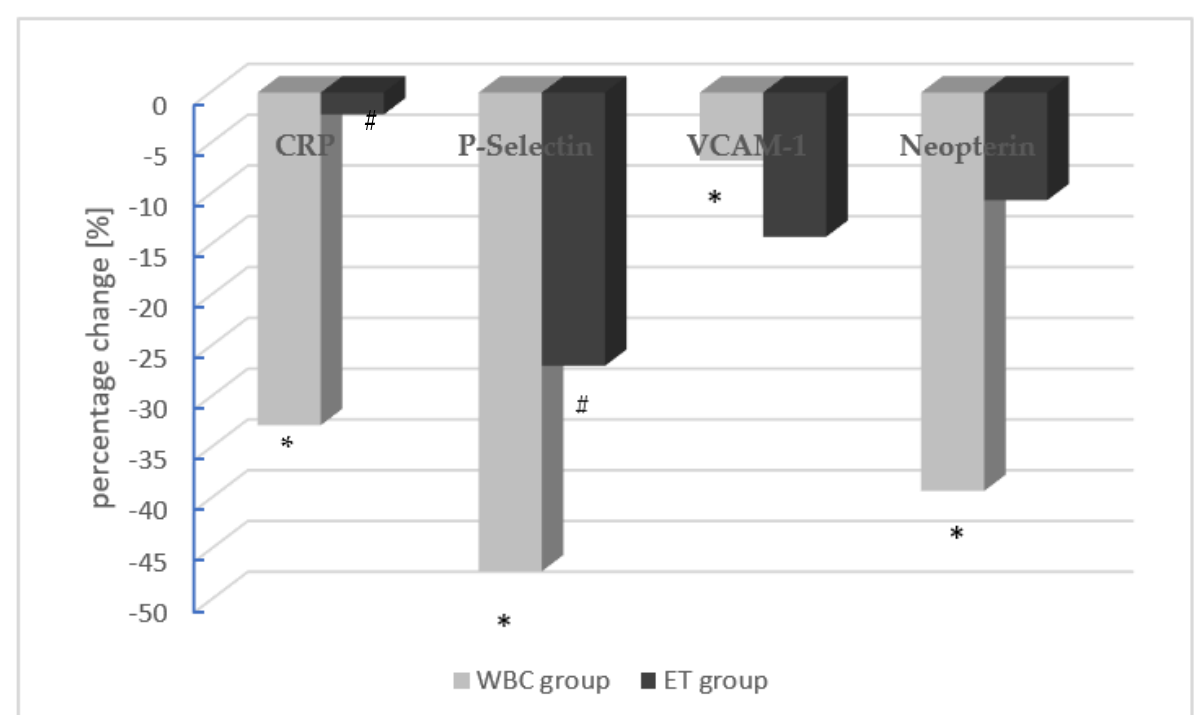
Figure 2. The mean percentage changes in endothelium function parameters in the WBC group (gray) and the ET group (black). The concentration of a given parameter at the first collection was assumed as 100%. Statistically significant differences between the first and second measurement (pre- and post-procedure) are marked as * and # in the WBC and ET groups, respectively (hsCRP: high-sensitivity C-reactive protein; sVCAM-1: soluble vascular cell adhesion molecule-1; (p): plasma; (s): serum). Table 3. Oxidative stress parameters (mean value ± standard deviation SD) in AS patients before and after the treatment in studied